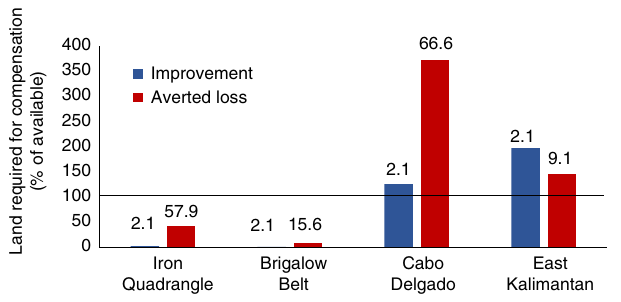
Fig. 3 The compensation required to achieve NNL of biodiversity for our best performing Averted Loss and Improvement policy designs (see Fig. 2). Numbers above bars show required multipliers, according to our simulated rates of biodiversity losses and gains. Columns show the required compensation area relative to the land available for compensation. In two cases (Cabo Delgado and East Kalimantan), the land required for compensation exceeds that available for protection or